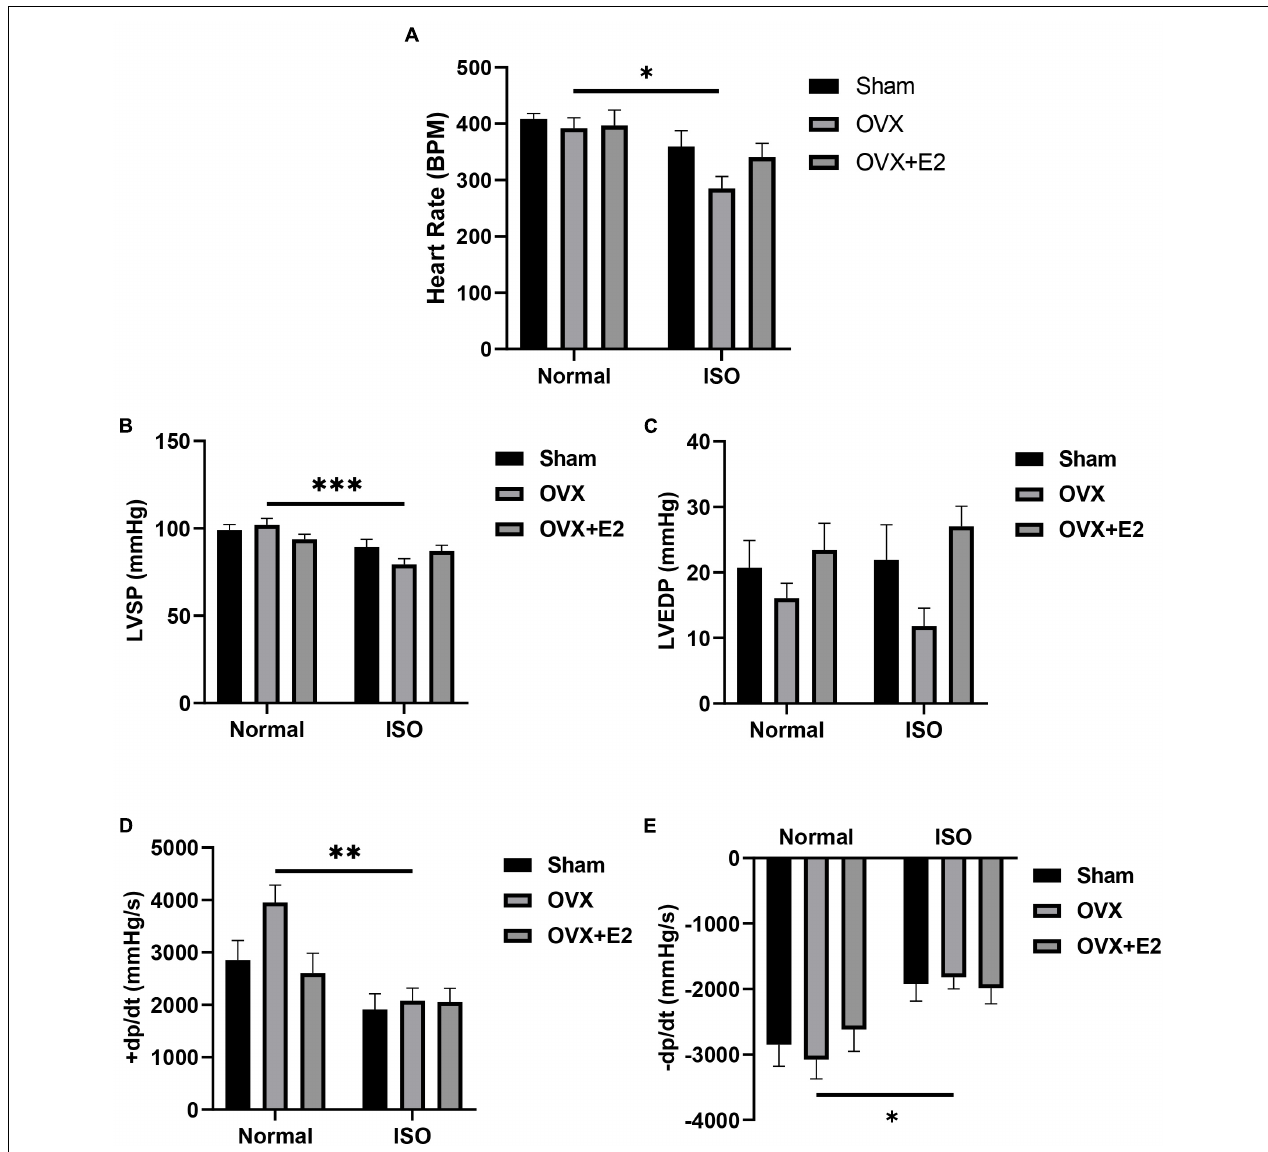
FIGURE 2 | Estrogen deficiency permits cardiac dysfunction chronic stress. (A) Graphical representation of heart rates (HR). (B,C) Left ventricular systolic pressure (LVSP) and left ventricular end-diastolic pressure (LVEDP) recordings depict cardiac dysfunction in OVX + ISO rats. (D,E) Rate of pressure development (+ dp/dt) and the rate of pressure development decay ( − dp/dt) further validate cardiac dysfunction in OVX + ISO rats. ( n = 7 rats/group). ∗ p < 0.05, ∗∗ p < 0.01, and ∗∗∗ p < 0.001. Data are presented as mean ± SEM. Data were analyzed using two-way ANOVA and Bonferroni’s multiple comparisons